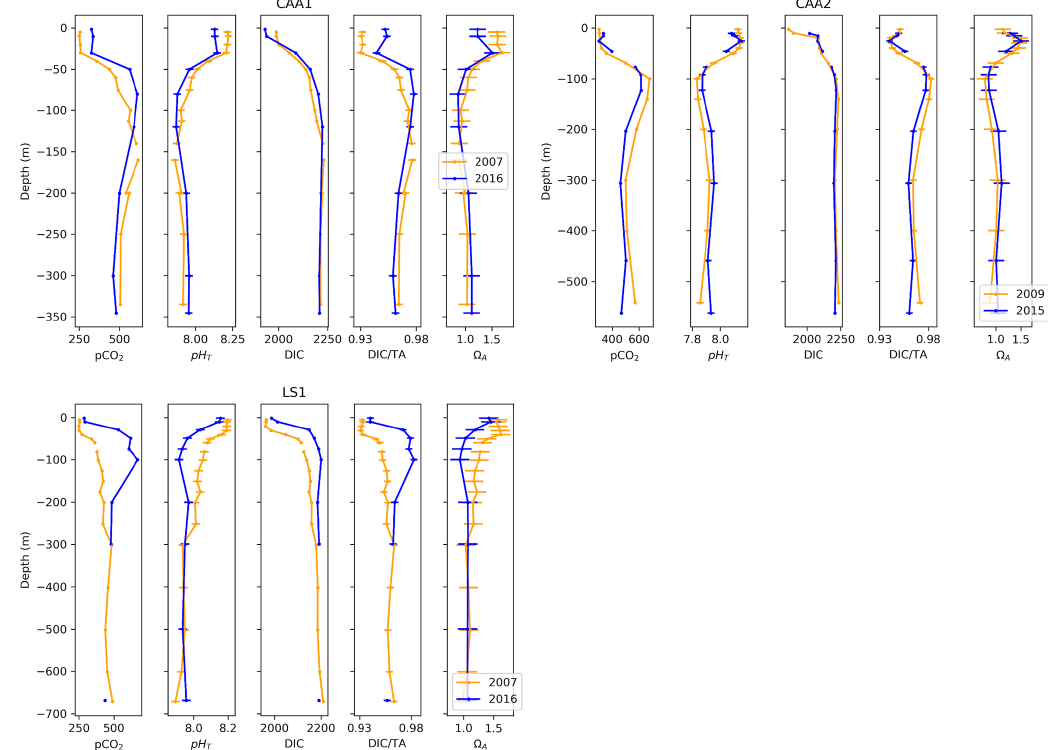
Figure 10. Depth profiles of p CO 2 , pH T , DIC, DIC /T A and (cid:127) A across time at one location in Lancaster Sound (LS1) and two locations in the Canadian Arctic Archipelago (CAA1,